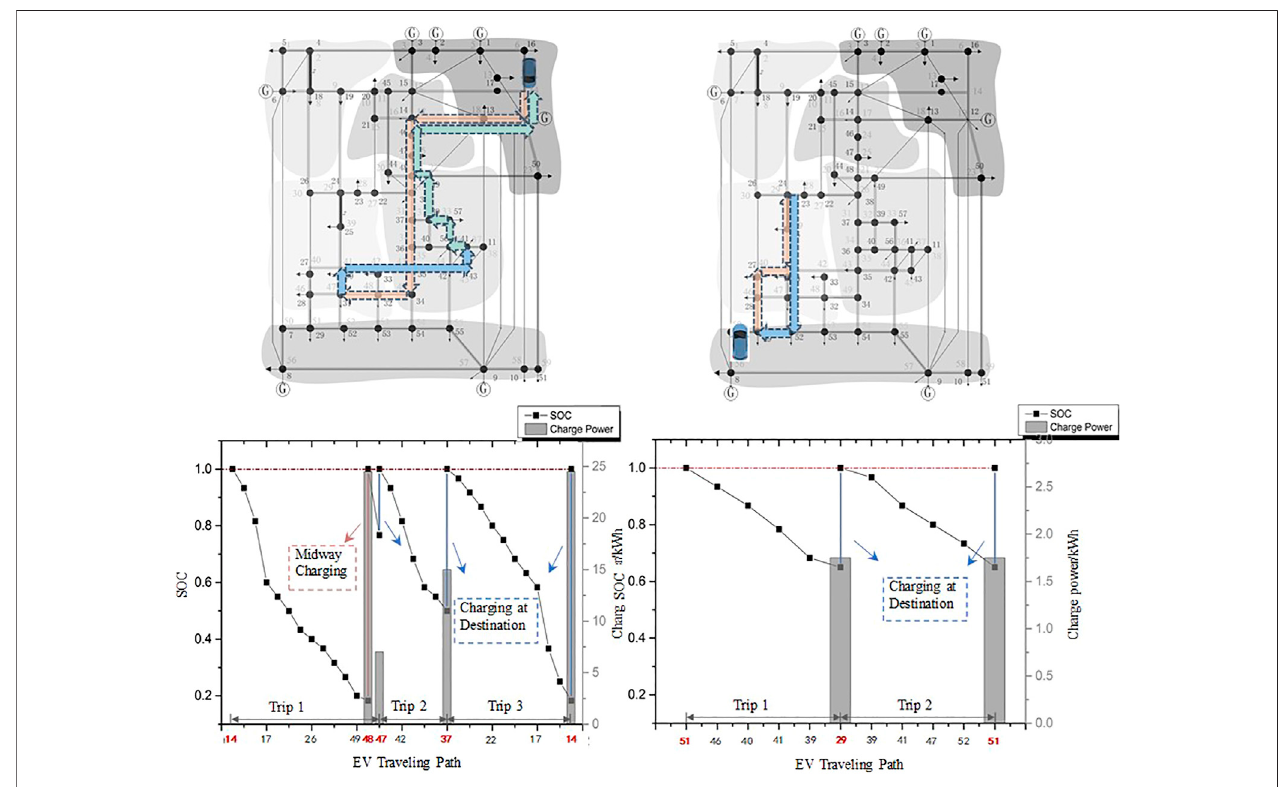
FIGURE 7 | The spatial-temporal EV mobile trajectory and corresponding SOC variation.